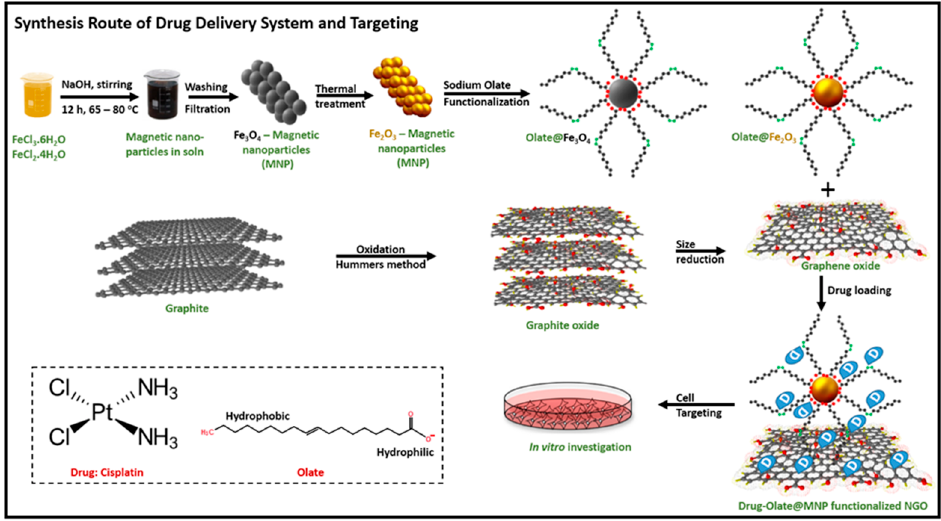
Figure 2. Schematic representation of the preparation of γ -Fe 2 O 3 @NGO.